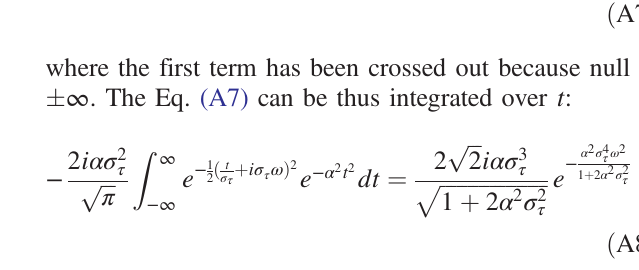
FIG. 13. Skew Gaussian distribution for different α ’